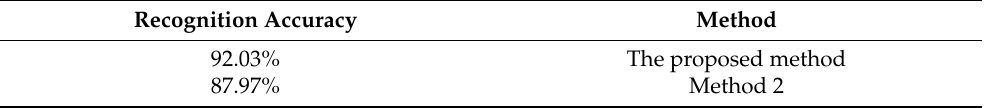
Table 4. The average recognition accuracy of two methods in the test set.